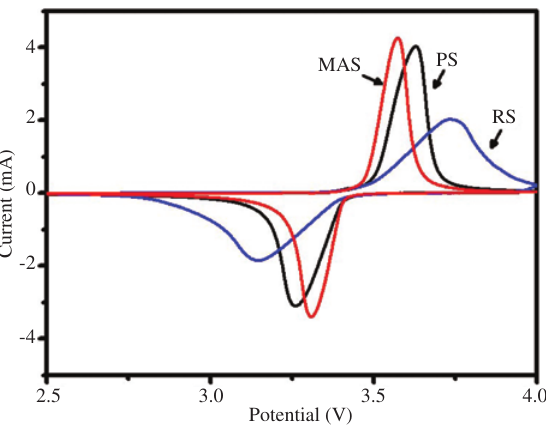
Figure 6: EIS plot of samples in frequency range from 100 kHz to 0.01 Hz.